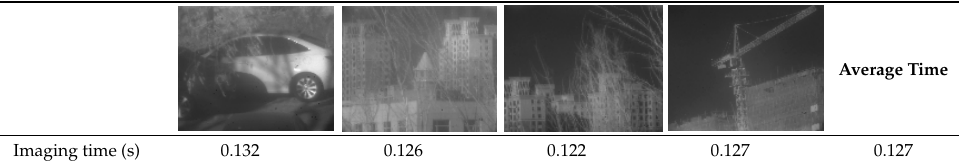
Table 2. Imaging time of various images.